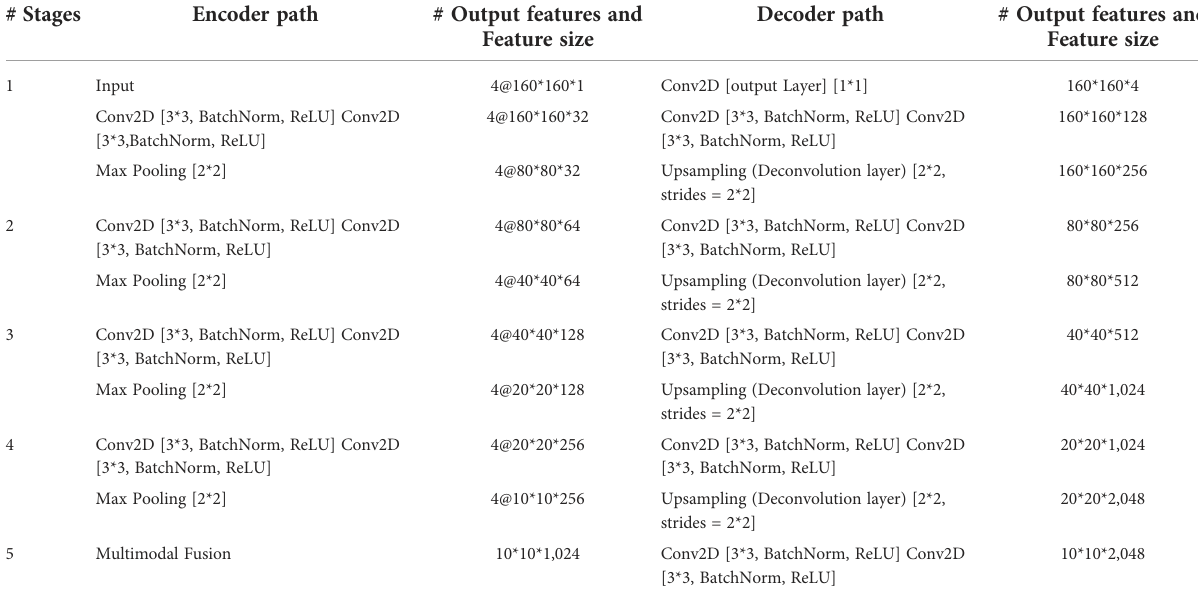
TABLE 1 Details of operations performed, and settings of layers in each encoding and decoding stage of the proposed network. #